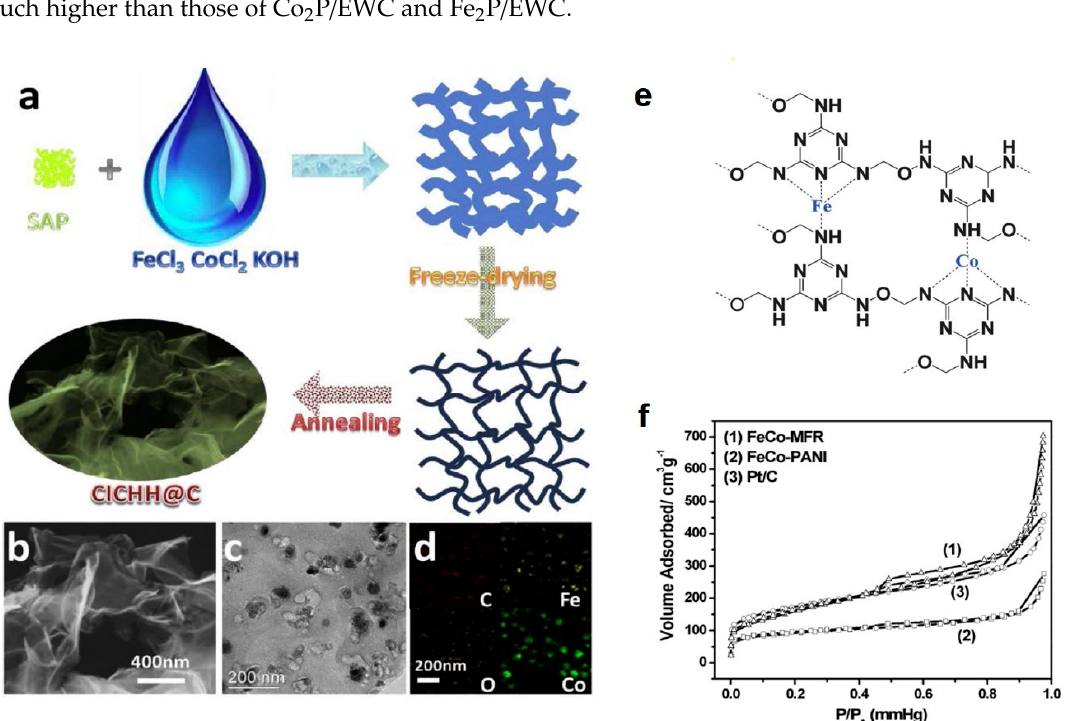
24 of 31 Figure 15. XANES spectra for ( a ) Co K-edge and ( b ) Fe K-edge; extended X-ray absorption fine